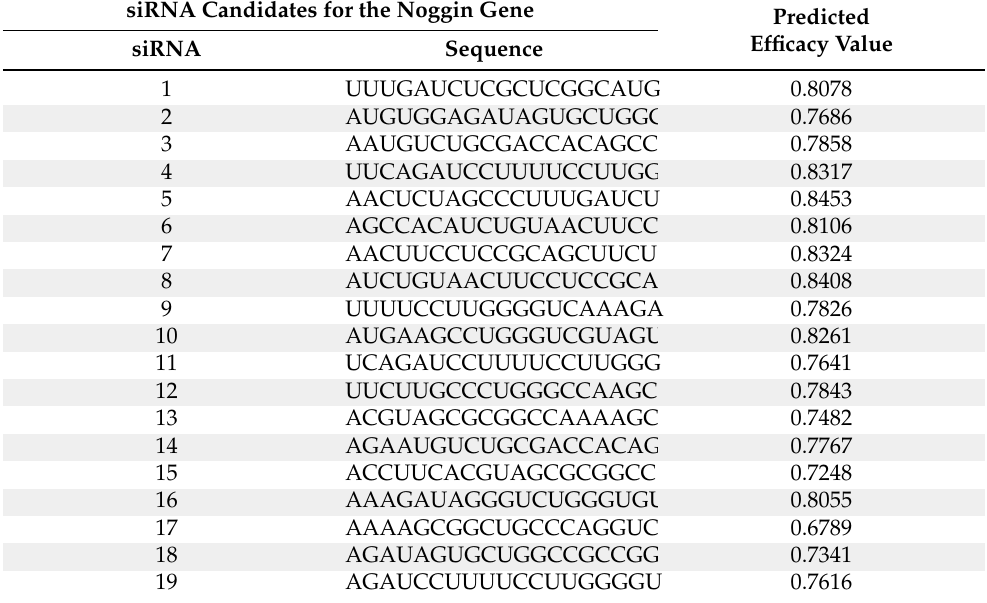
Predicted Efficacy Value